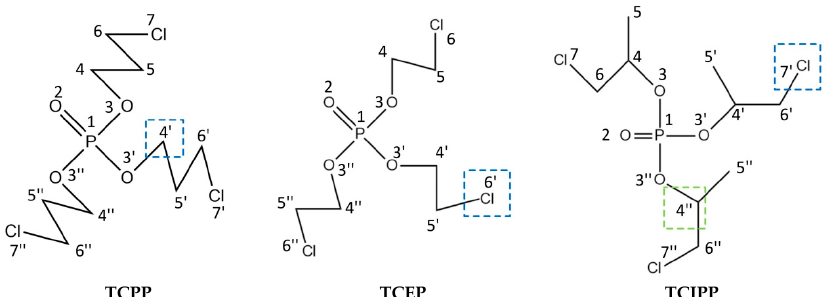
Figure 1. Three-dimensional congruent map of Hypo C1 and TCPP, TCEP and TCIPP.